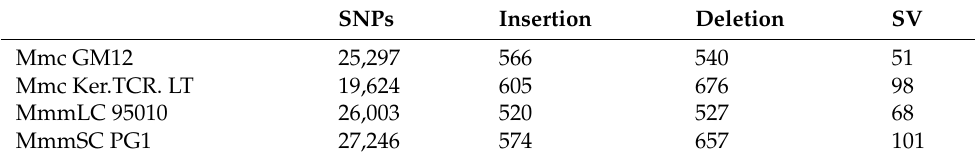
Table 4. Statistical results of SNP, InDel, and SV between Mmc HN-A and target